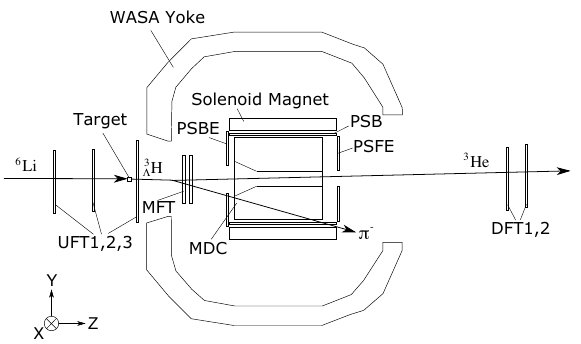
Figure 2. Experimental setup of the WASA-FRS HypHI